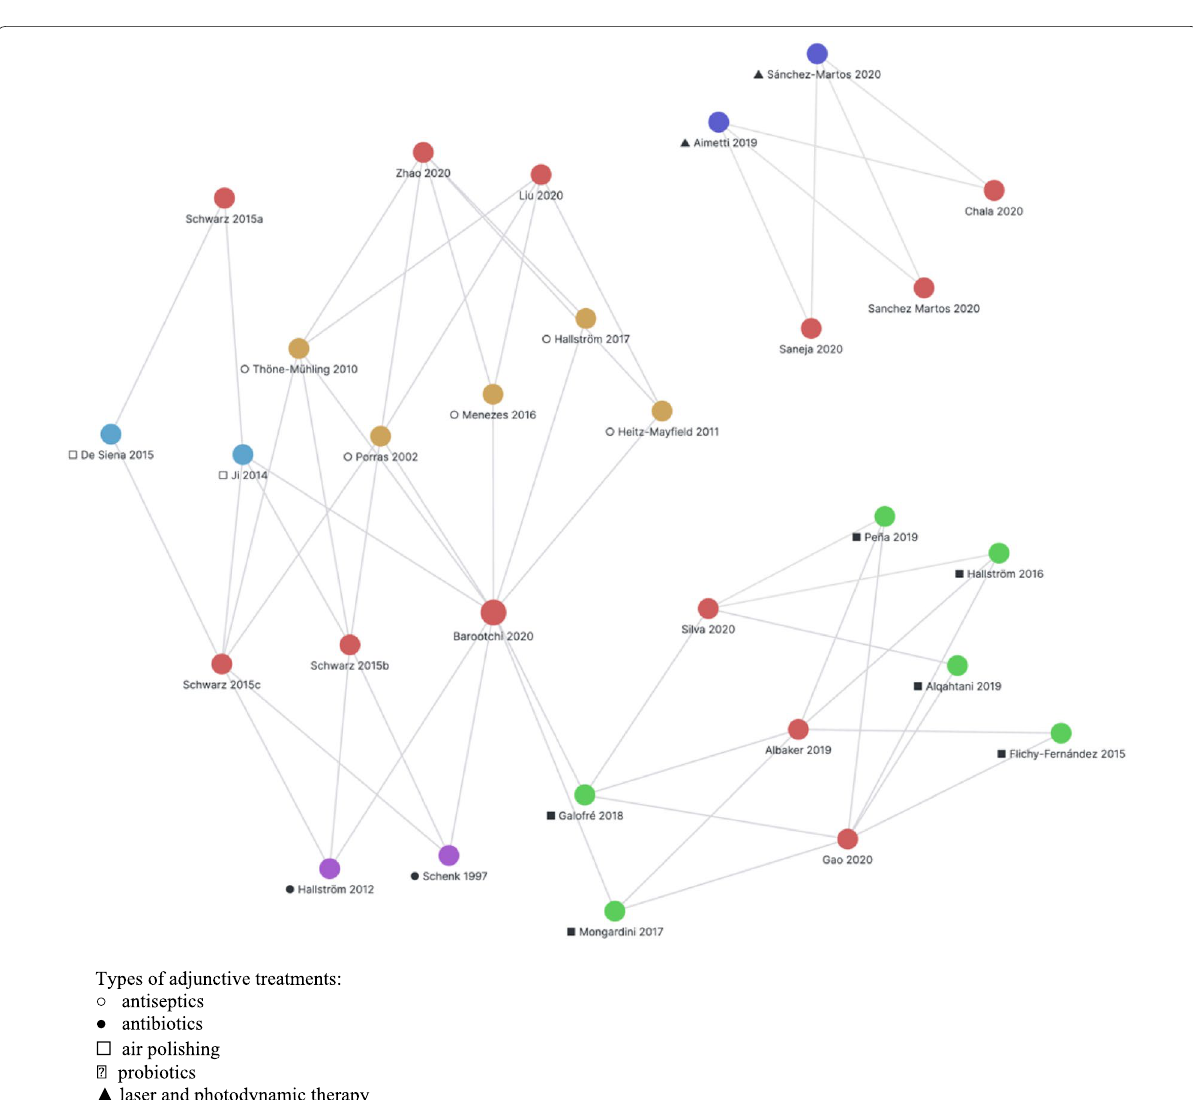
Fig. 2 Network of included systematic reviews and primary studies. The systematic reviews and the primary studies were represented by nodes. Each systematic review was linked to the primary studies that were part of it. Types of adjunctive treatments: open circle antiseptics, filled circle antibiotics, open square air–polishing, filled square probiotics, filled triangle laser and photodynamic